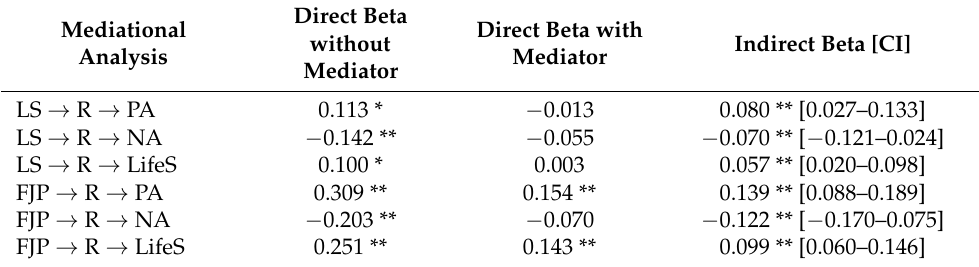
Table 3. Results of mediational analysis. Mediational